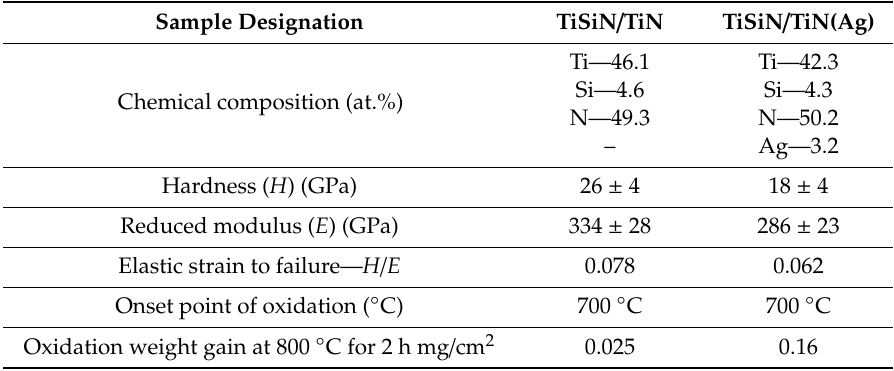
Table 1. Coatings’ denomination, chemical composition and mechanical